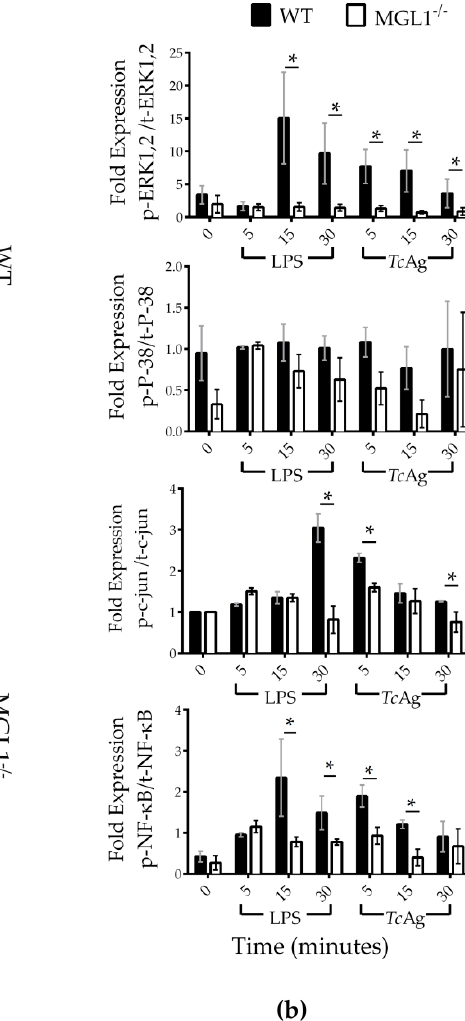
Figure 7. MGL1 − / − BMM φ exhibit reduced activation of ERK1 / 2, c-Jun and NF κ -B signaling pathway in response to Tc Ag. ( a ) WT and MGL1 − / − BMM φ were stimulated for 5, 15 and 30 min with LPS (100 ng / mL) or Tc Ag (25 µ g / mL). In total protein lysates of M φ were measured the phosphorylation of ERK1 / 2, p38 and NF κ B by western blot analysis. Western blotting for the indicated proteins. ( b ) Densitometry analysis for the indicated proteins as described above. Results are representative of at least three separate experiments each with three biological replicates. Densitometry analysis of the indicated proteins was normalized first, to GAPDH protein, and next to total protein expression as appropriate. Data shown are mean ± SEM (n = 6), * p < 0.05.